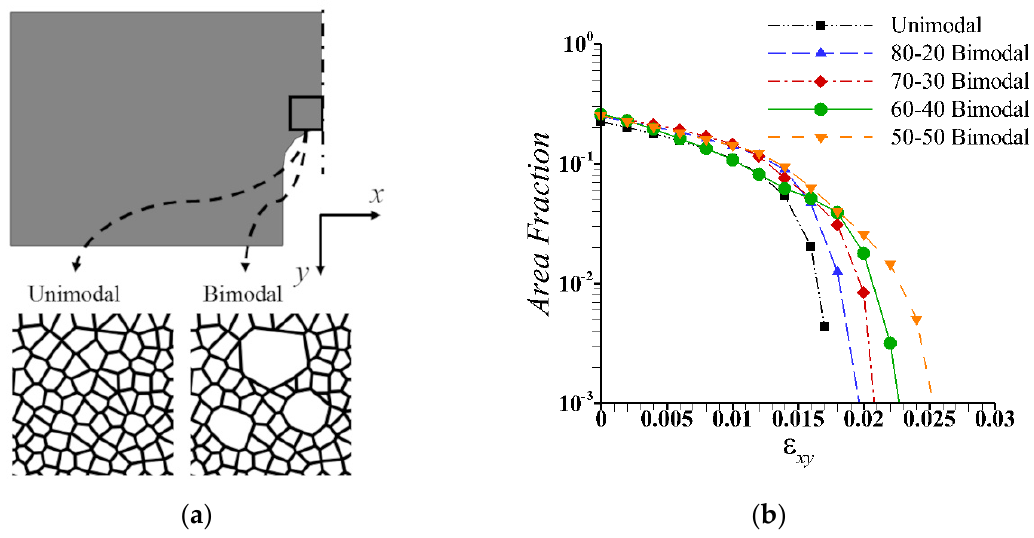
Figure 14. ( a ) Schematic showing the finite element model of one half of the single-edge specimen together with zoomed view of a unimodal and bimodal grain microstructure close to notch tip. ( b ) Variation in the area fraction of various levels of shear strain, ε xy , in 200-by-200 µ m 2 region close to the notch in a unimodal and four bimodal microstructures deformed to a macroscopic normalized extension, 𝛿/𝐿 (cid:2868) , of 0.015.